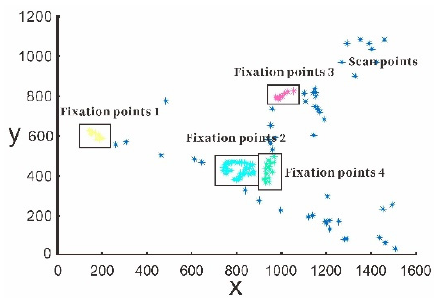
Figure 4. Fixation point acquisition using Identification-Deviation Threshold (I-DT) algorithm.